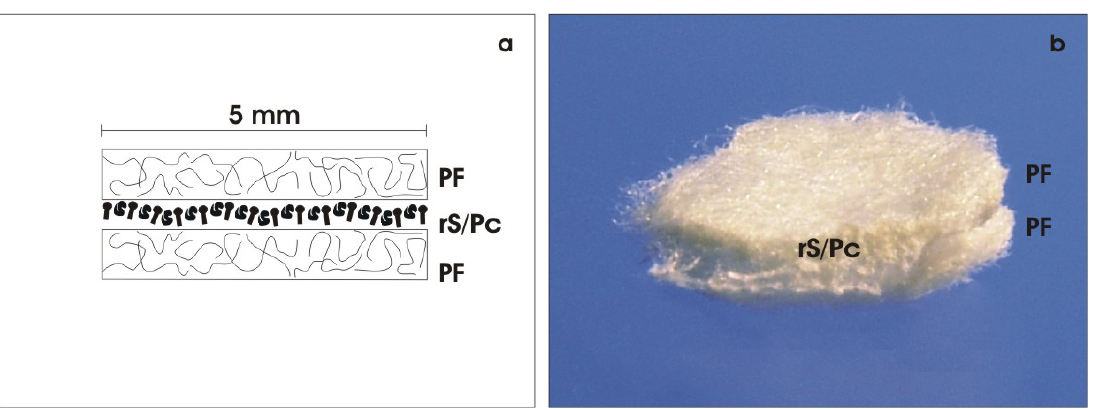
Figure 3. Creation of an artificial interstitium. (a) An artificial interstitium for the culture of renal stem/progenitor cells (rS/Pc) is made by mounting the isolated embryonic tissue between two layers of polyester fleece (PF). (b) Photographic illustration of a basic sandwich set-up containing isolated embryonic tissue with rS/Pc between layers of